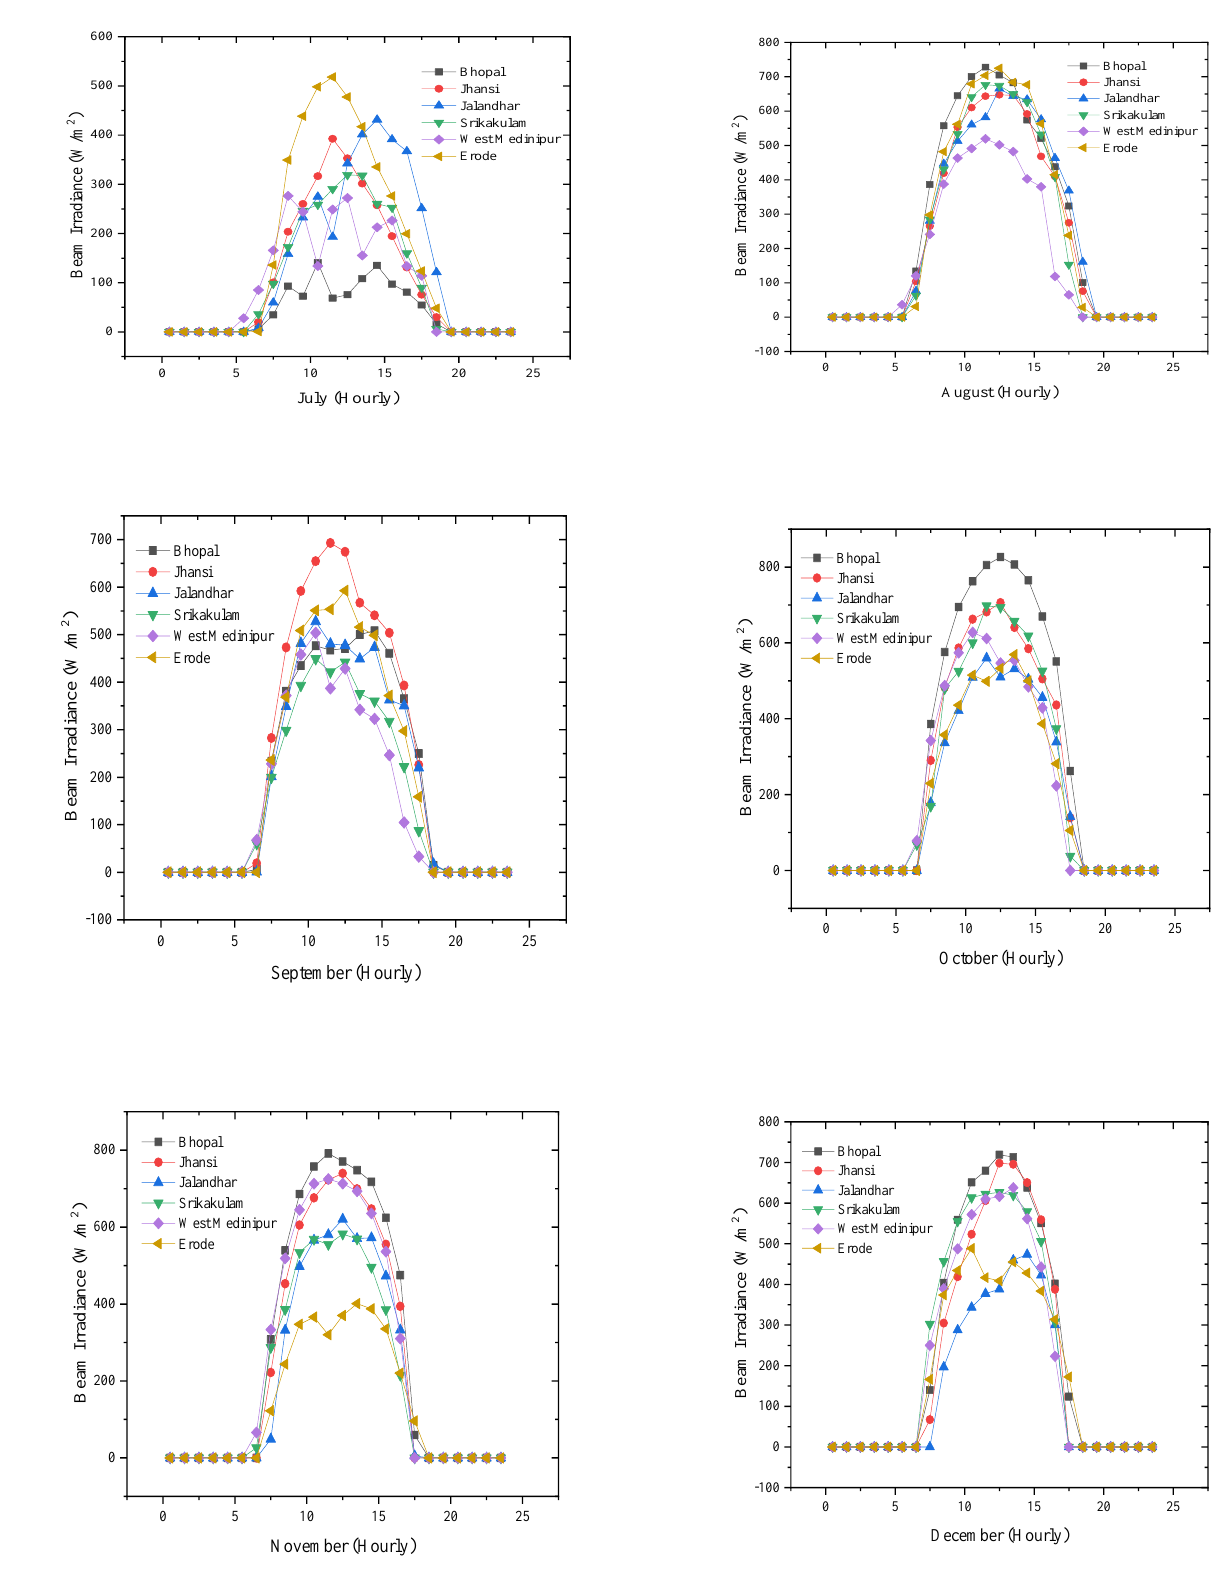
Figure 4. Monthly DNI for the six different locations of the study.